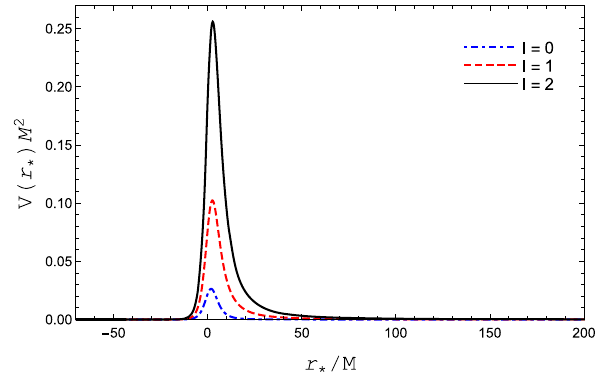
Fig. 7 Effective potential with ε = 1, for modes l = 0 (blue dot- dashed line), l = 1 (red dashed line) and l = 2 (black solid